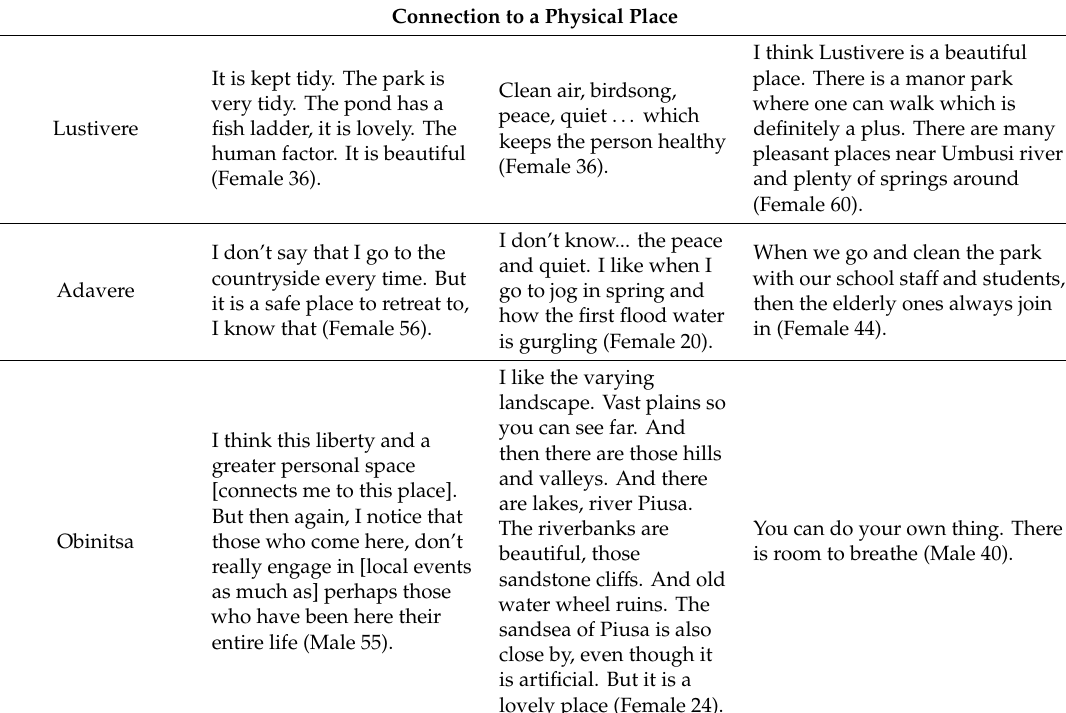
Table 5. Connection to a Physical